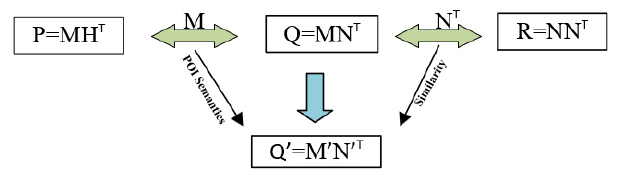
Figure 3. Context-coupled matrix factorization.